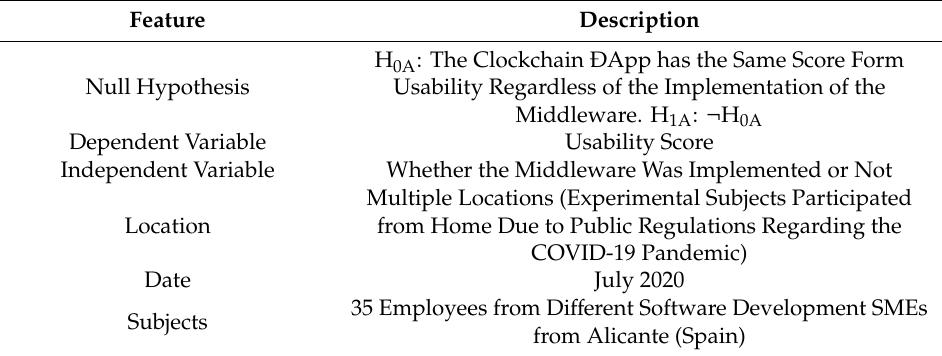
Table 1. Main Features of the Experiment.